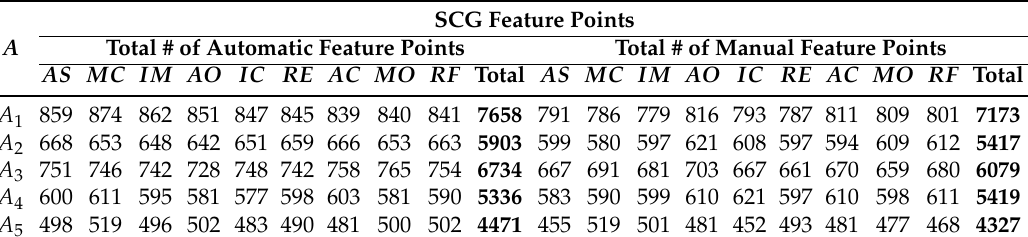
Table 7. Sample result of SCG feature point delineation mechanisms.